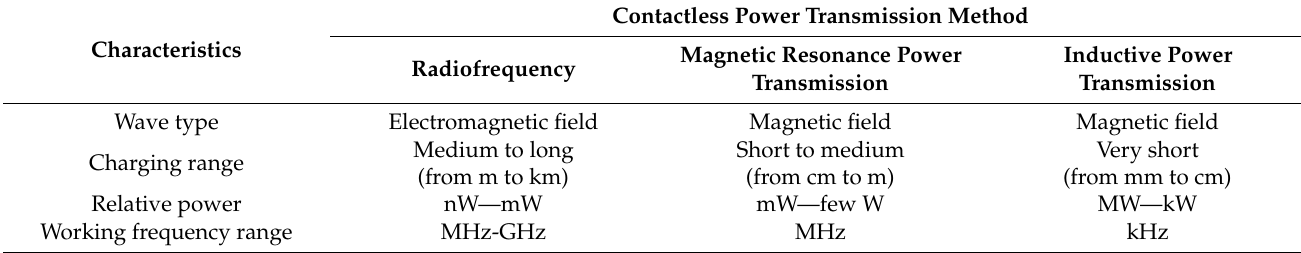
Table 2. Characteristics of wireless power transmission systems.